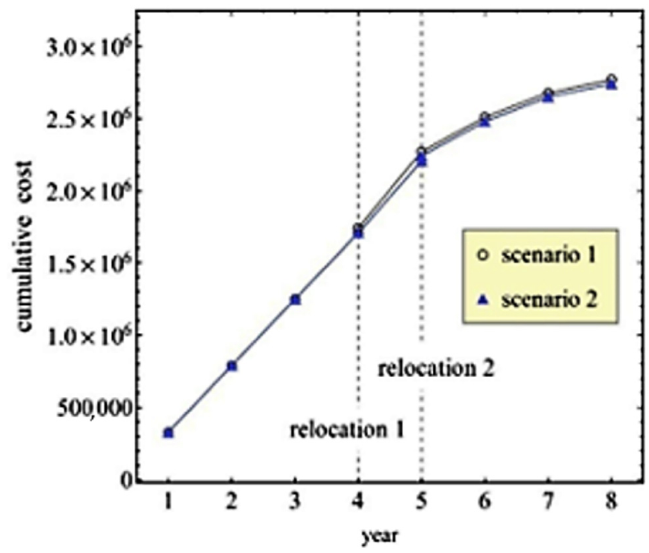
Figure 9. Comparison of cumulative costs between scenarios.